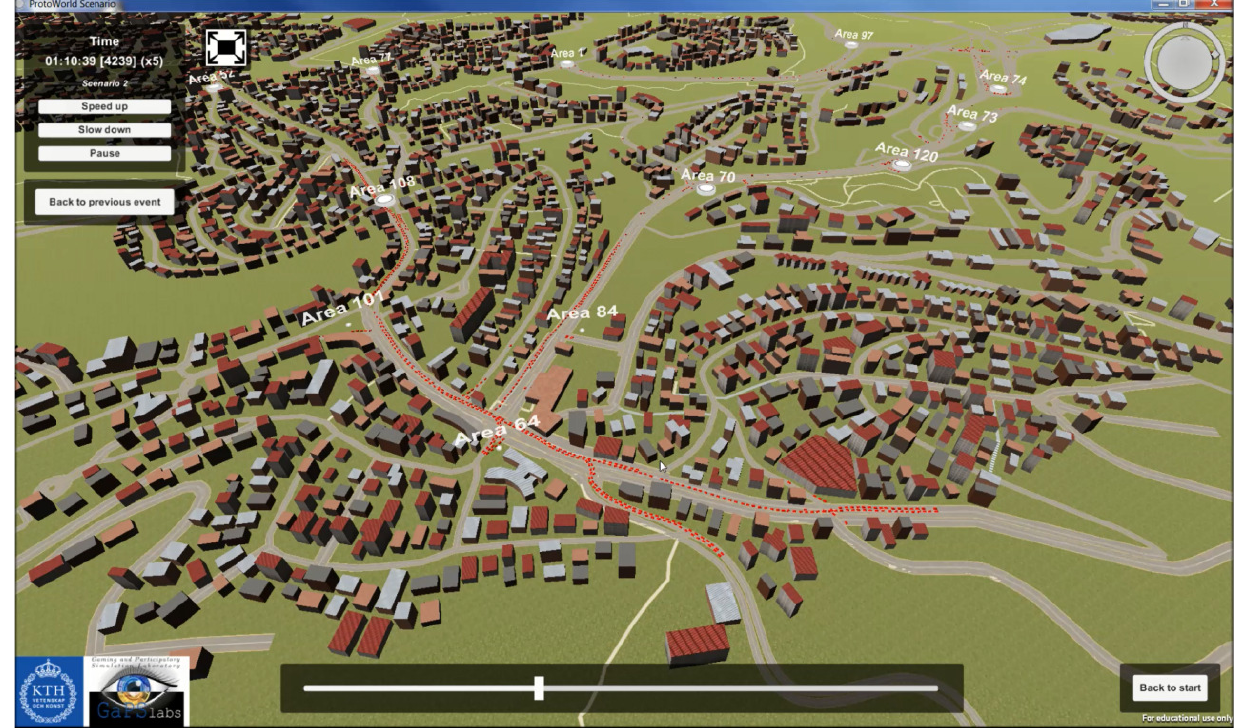
Figure 2. Macro view of the game in